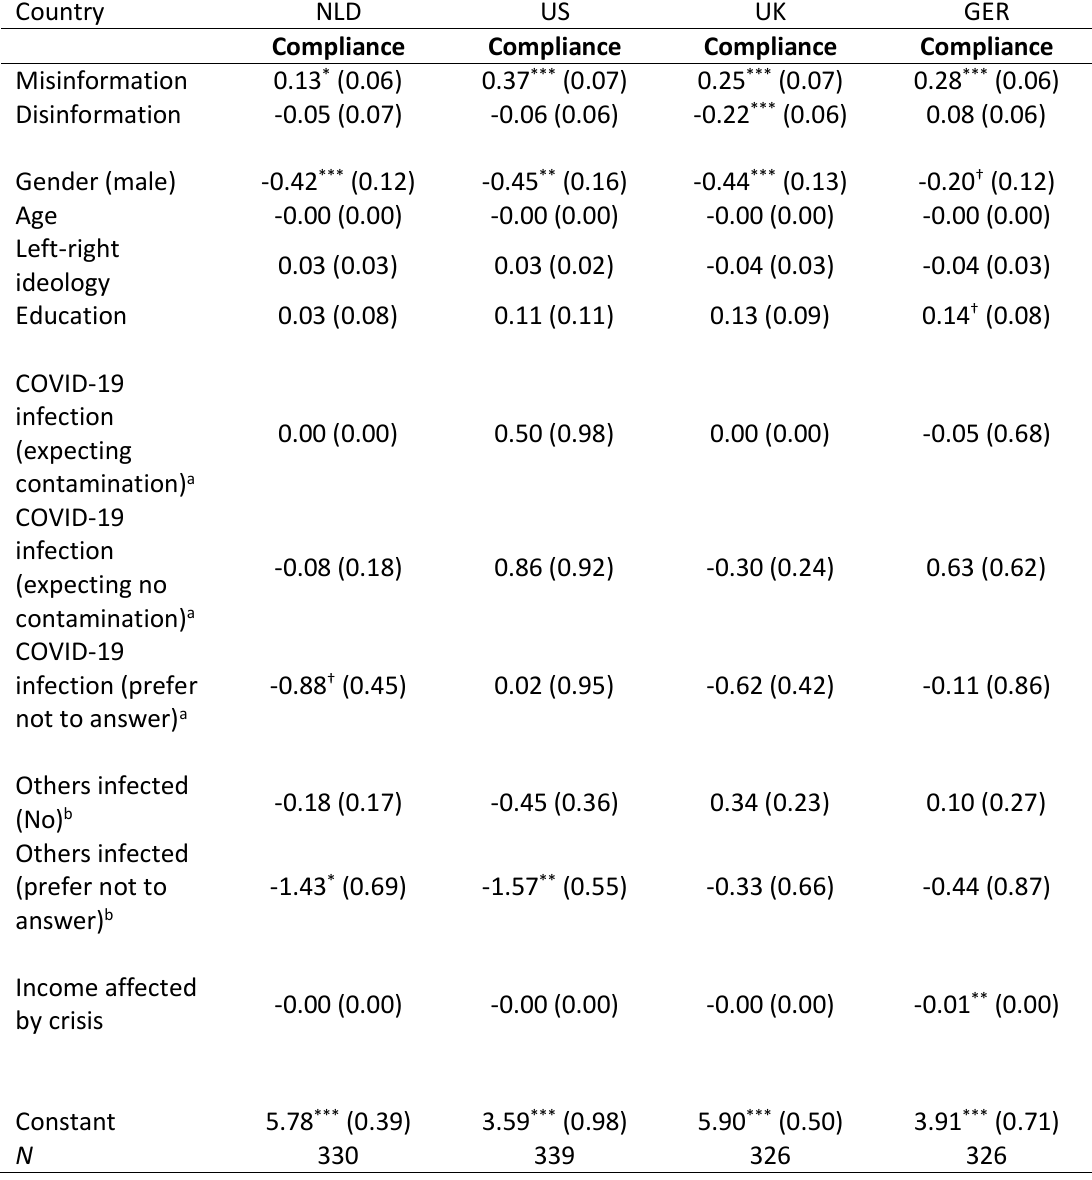
Table B1 . Willingness to comply predicted by levels of perceived mis- and disinformation, specified per